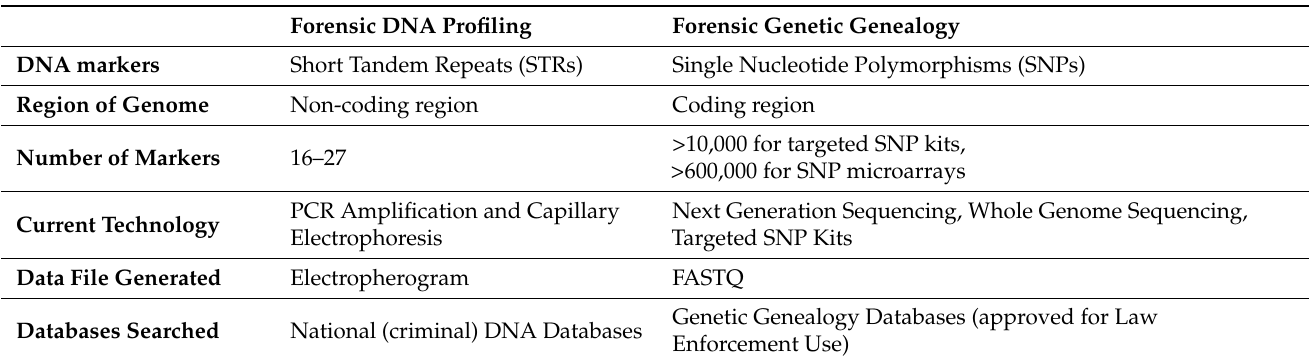
Table 1. Summary of differences for Forensic DNA Analysis and Forensic Genetic